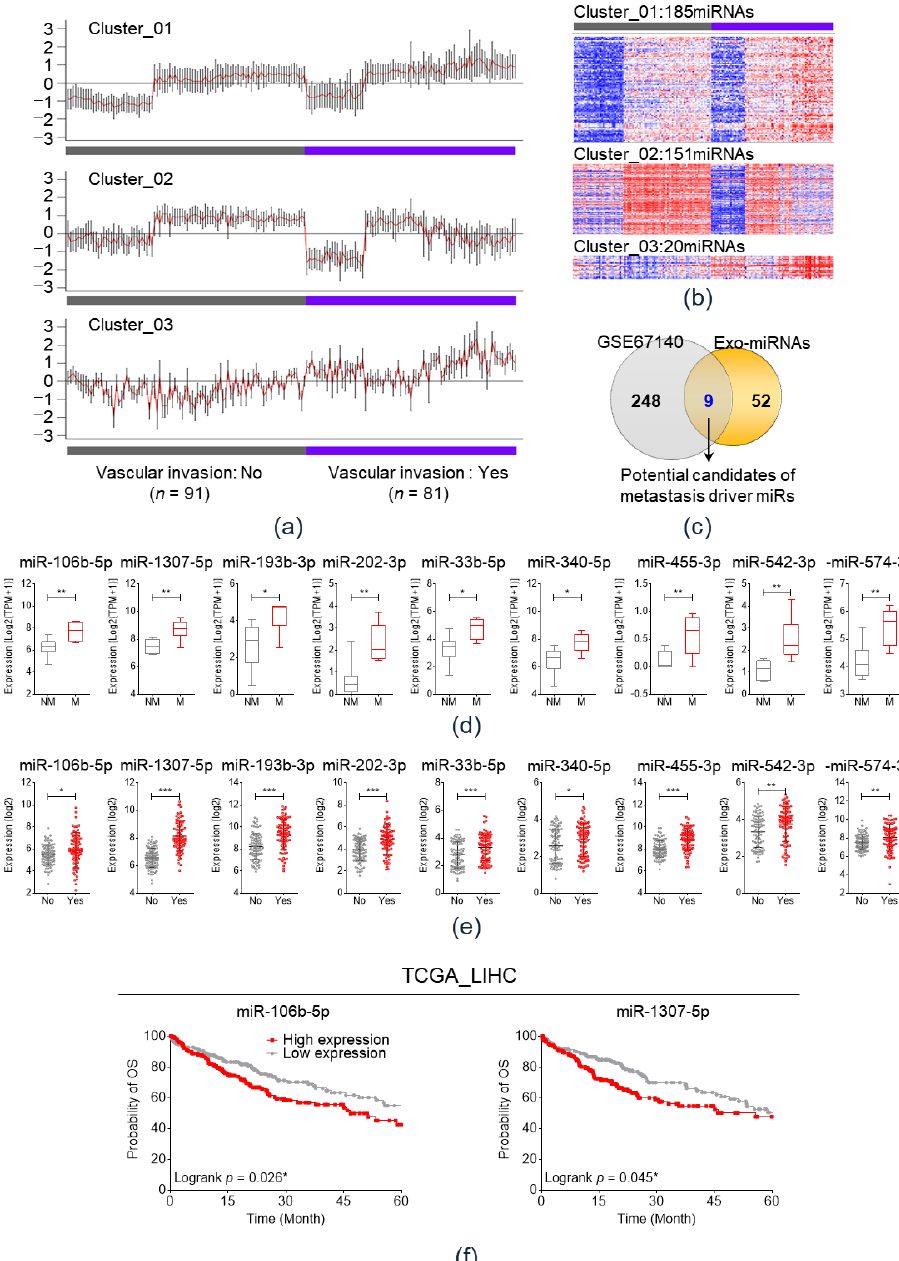
Figure 3. Integrative analyses of two different public RNA expression datasets ( a ) On Cluster analysis, miRs could be categorized into three clusters on the basis of their expression patterns according to vascular invasion status in GSE67140. ( b ) Heatmaps of miR expression in each cluster based on the vascular invasion status. ( c ) Venn diagram analysis to select potential candidate metastasis driver miRs. ( d ) Comparison of the expression of nine miRs between metastasis (M) and non-metastasis (NM) groups based on the expression of 14 plasma exosomal small RNA sequencing data. * p < 0.05; ** p < 0.01. ( e ) Comparison of the expression levels of nine miRs based on the vascular invasion status in the GSE67140 cohort. * p < 0.05; ** p < 0.01; *** p < 0.001. ( f ) Kaplan – Meier plot of overall survival based on the expression of miR-106b-5p and miR-1307-5p in TCGA_LIHC. * p < 0.05. NM, non-metastasis; Meta, metastasis; TCGA_LIHC, The Cancer Genomic Atlas Liver Hepatocellular Carcinoma.